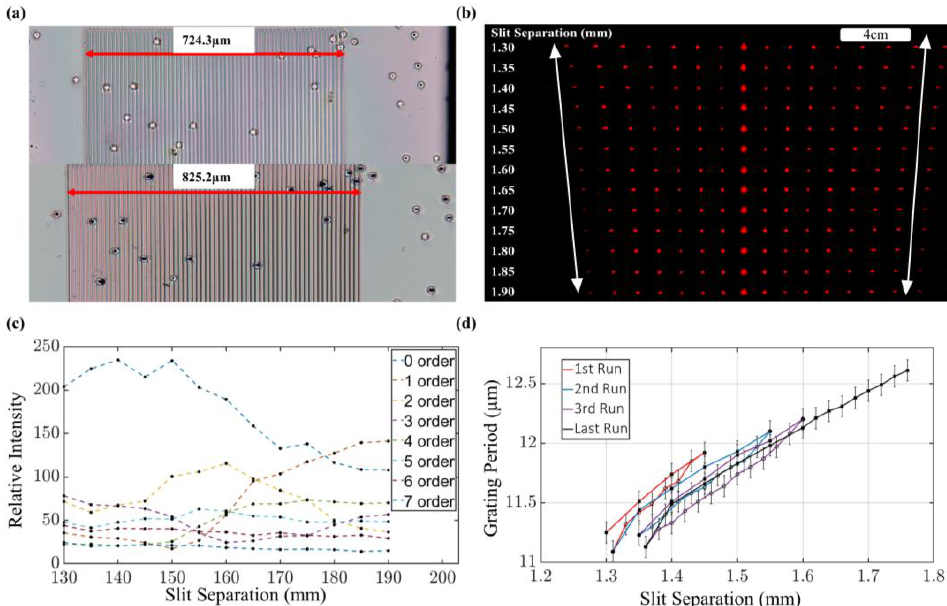
Figure 7. Mechanically tuning the 1D diffraction grating. ( a ) Polarization optical microscope (POM) images which show the grating in the undistorted state and the grating after the film has been extended by the maximum amount. ( b ) Replay field images which show the change in the diffraction pattern observed in the far-field as the grating is extended and contracted. ( c ) Intensity of each diffraction order as a function of slit separation. The dashed lines between the measured values are to guide the eye only and the estimated error in these relative intensity measurements is ± 4%. ( d ) Grating period as a function of the separation between the metal plates (the slit) on which the samples were placed and which triggered either an extension or contraction of the film. The values for the grating period were obtained from POM images. Solid squares represent an extension of the film while open circles indicate a contraction of the